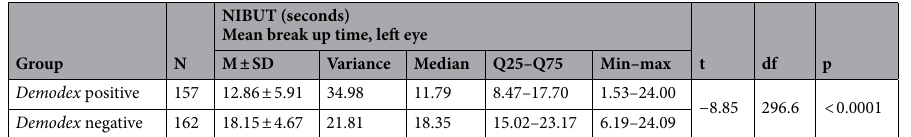
Table 6. Descriptive statistics of the mean break up time in the left eye in patients with and without Demodex infestation and results of the t-test with Cochran-Cox correction. Arithmetic mean (M), standard deviation (SD), interquantile range (Q25–Q75), degrees of freedom (df), t-value (t), p-value (p).